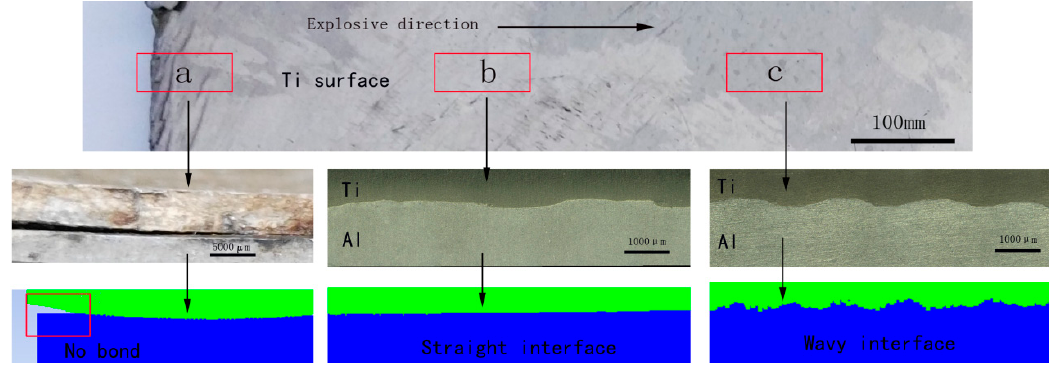
Figure 10. The interface of the Ti/Al composite plate fabricated by explosive welding.